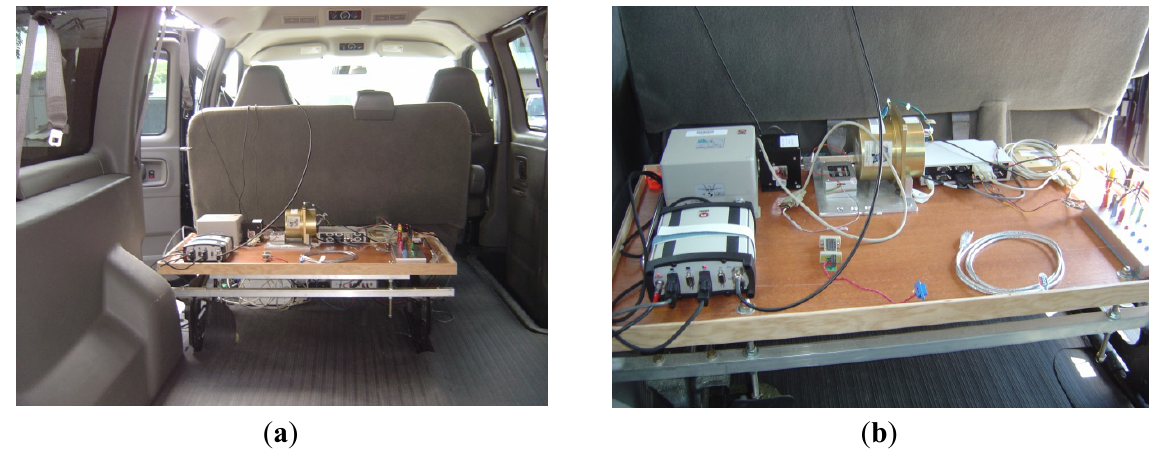
Figure 5. Experimental setup including inertial systems, GPS and data acquisition modules mounted inside land vehicle.